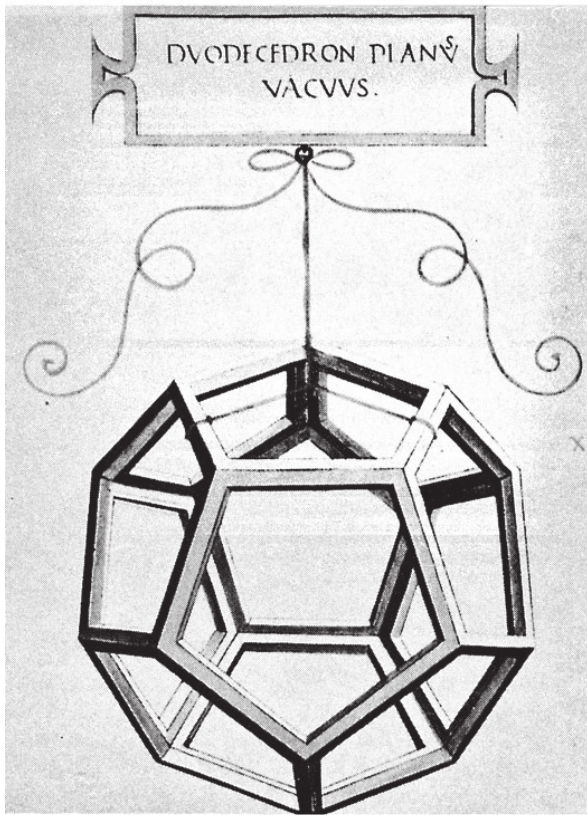
Fig. 4. Da Vinci’ s engraving of a regular dodecahedron, whose ver- tices locate the relative positions of carbon atoms in the fullerene, C20.